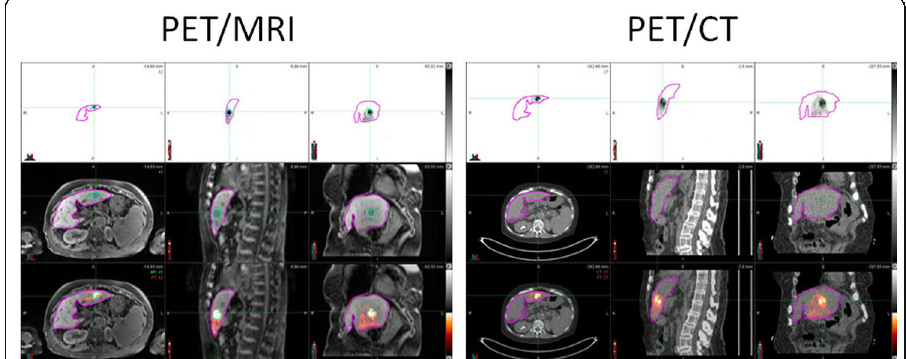
Fig. 2 PET/MRI and PET/CT images of the subject with the highest mean liver dose difference of 18.5%. In the first row, there are PET images, in the second row MRI and CT images, respectively, and in the third row fused PET/MRI and PET/CT images, respectively. Due to different field of view and voxel sizes in PET/MRI and PET/CT, the size of the images is different for different modalities and different studies. However, the distribution of 90 Y microspheres is practically identical. The mean liver dose obtained from PET/CT was 38.81